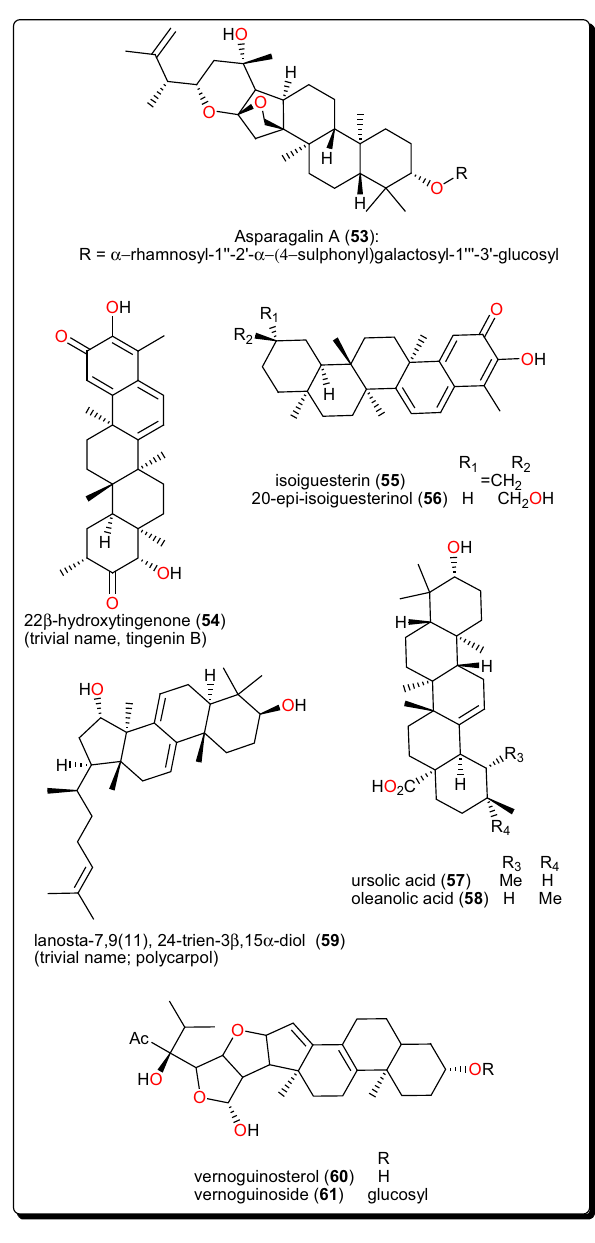
Fig. 10 Triterpenoids with antiparasitic